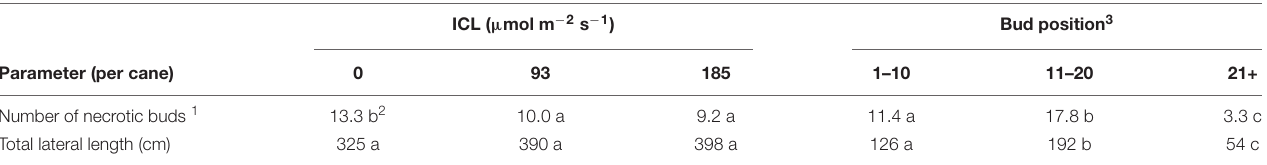
TABLE 7 | Total number of necrotic buds and total lateral length (destructive measurement at start of autumn cycle, 24–28 July). No significant interaction between bud position and spring ICL intensity was